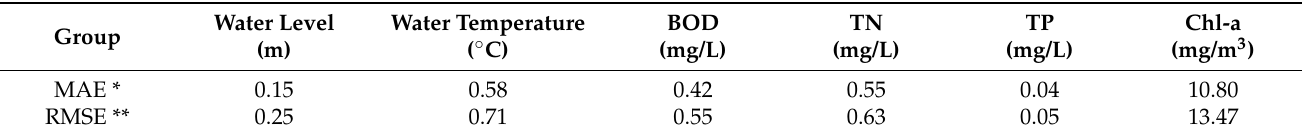
Table 5. Model performance according to the parameter